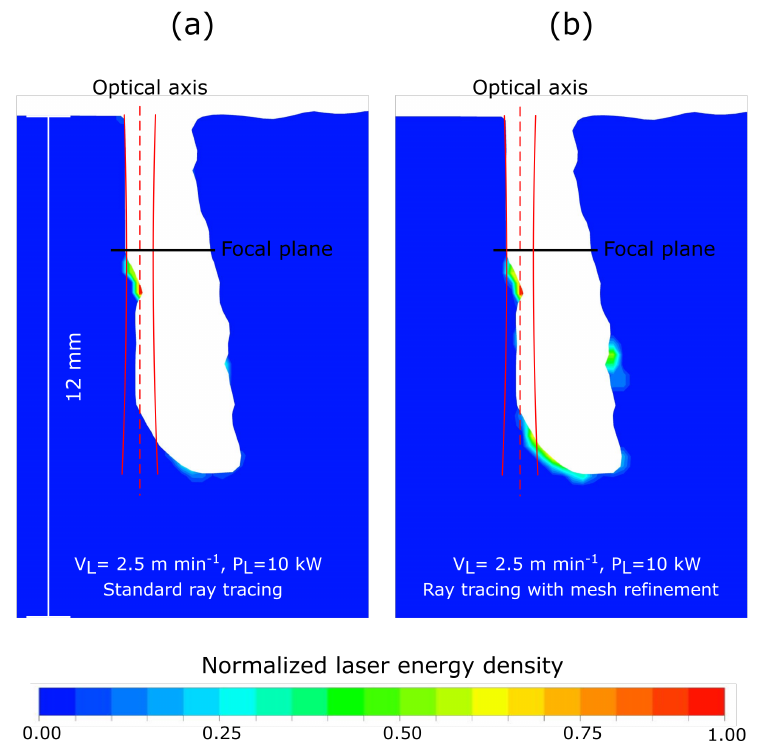
Figure 10. Distribution of the laser energy calculated with the ( a ) standard and ( b ) virtually refined ray tracing algorithms on a predefined keyhole